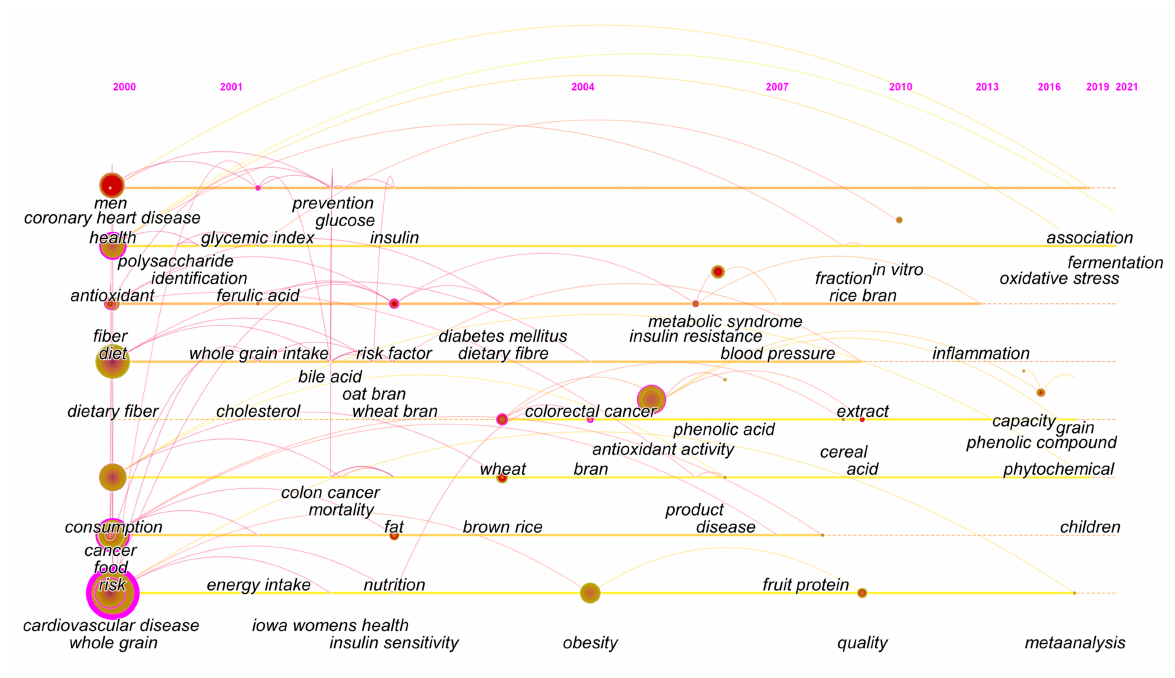
Figure 4. The timeline of keywords